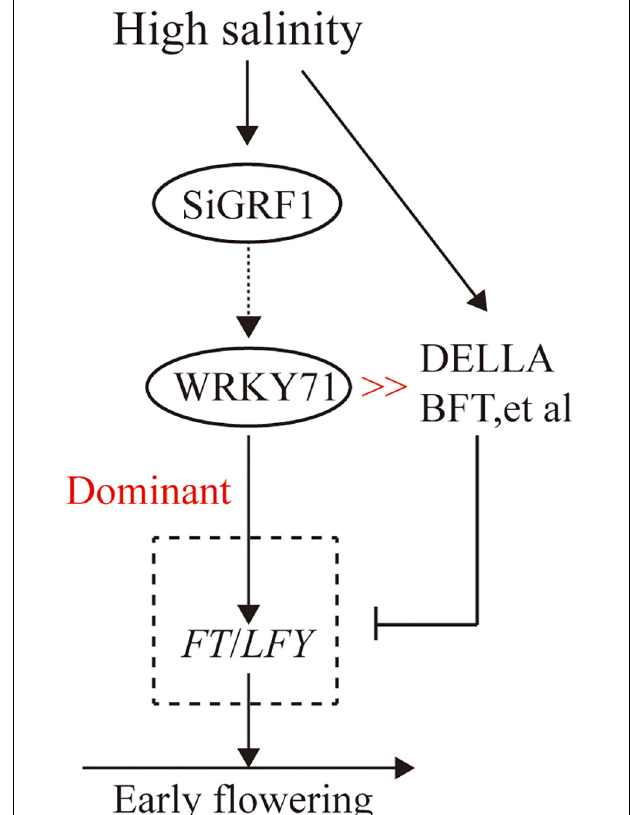
FIGURE 10 | Proposed model of SiGRF1 function in flowering plants exposed to salinity treatment. High salinity promotes DELLAs, BFT, etc., and